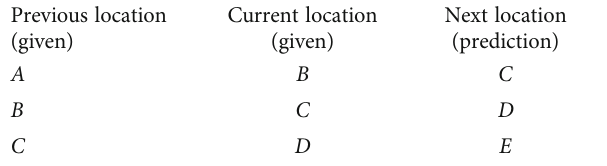
Figure 7: Sample graph 2 for Table 1: Data set with three types of locations.